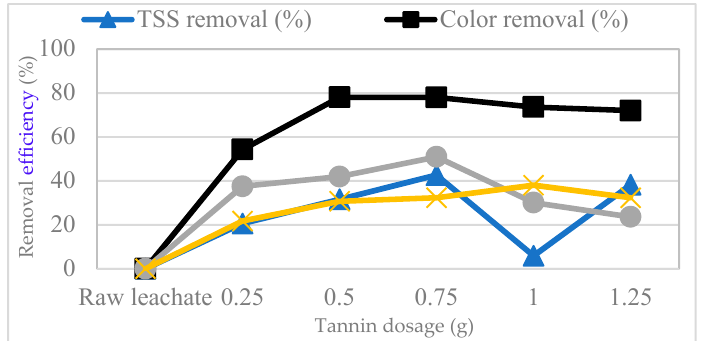
Figure 2. Effect of tannin dosage on chemical oxygen demand (COD), color, total suspended solids (TSS) and NH 3 –N removal from leachate at a pH of 8.18, 250 rpm for 15 min, 60 rpm for 30 min and settling for 30 min.